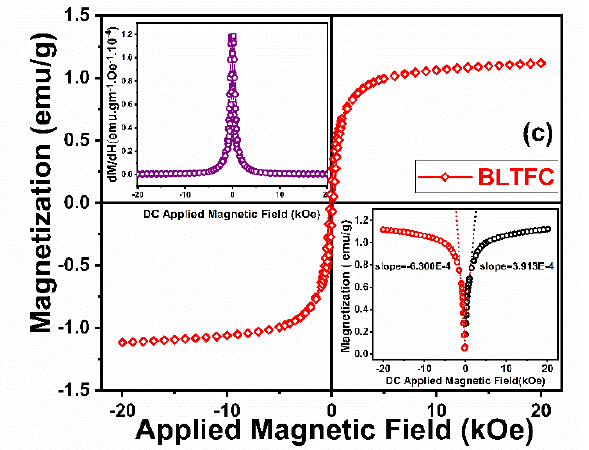
Figure 6. ( a – c ) Magnetic hysteresis loops (M vs H curves) of BDTFC, BSTFC, and BLTFC samples, (inset) Variation of (dM/dH) with the applied field.